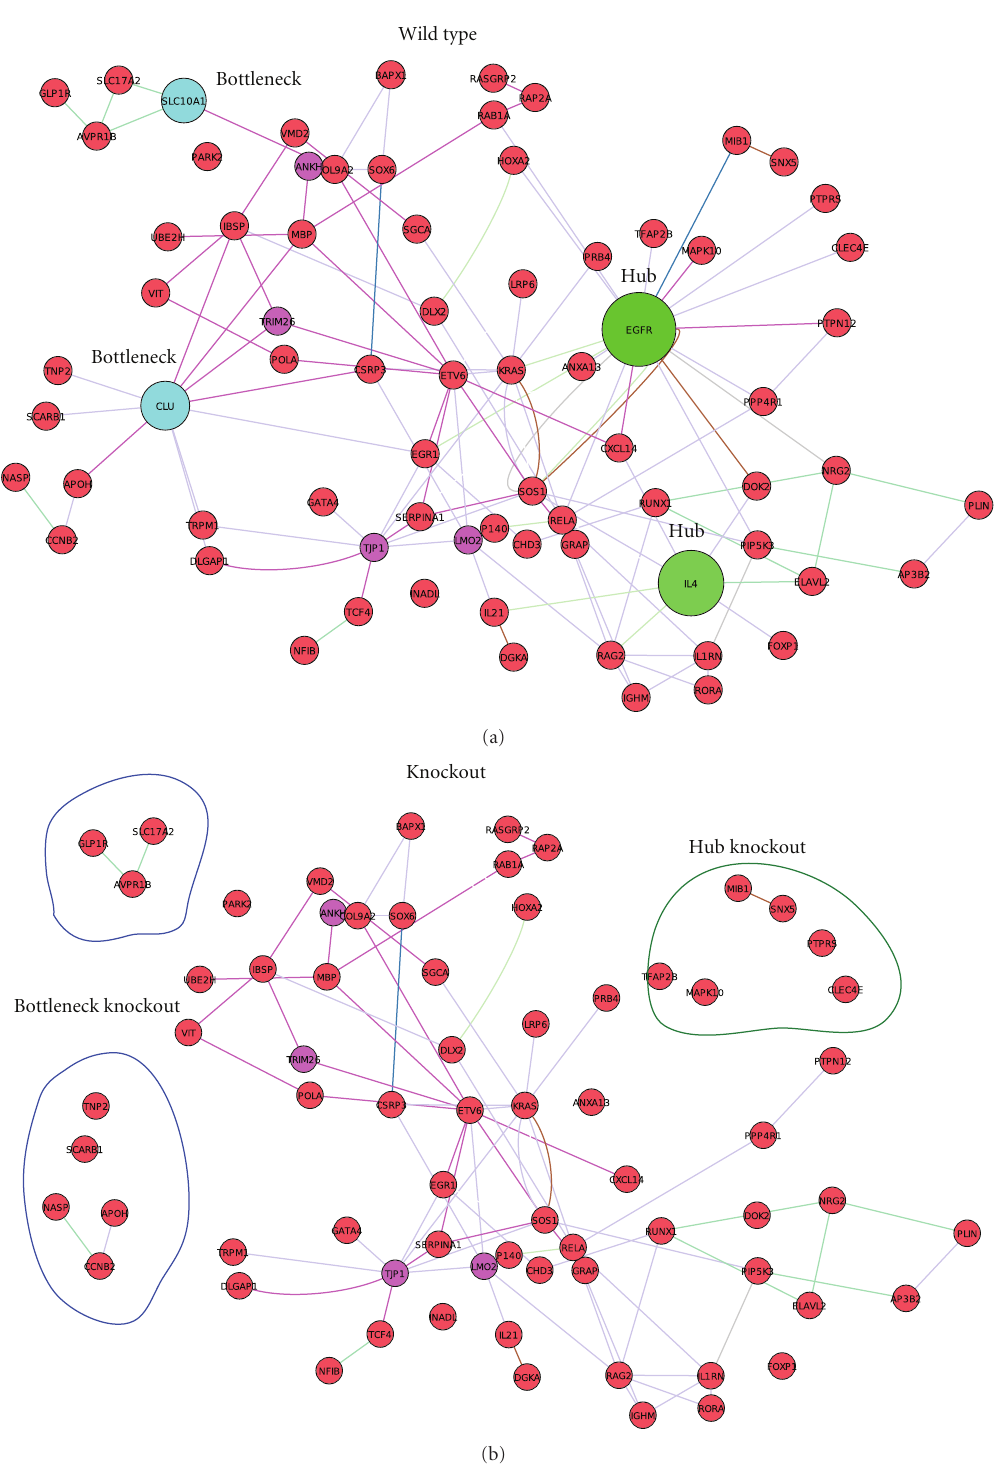
Figure 5: Samples of in silico gene knockout in the network enhanced by HCMV entry. (a) Entire wild-type network enhanced by HCMV entry with highlighted genes with big size to be knocked out. Blue: potential bottleneck nodes; green: potential hubs. (b) Knocking out hubs and bottlenecks alter network structure. Knocking out hubs decreases local subnetwork linkages while most of their linked neighbors would not a ff ected. Highlighted in green circle are the consequences of knockout EGFR and IL4 with only 6 genes and 1 gene, respectively, a ff ected by knockout, but most of genes linked to EGFR and IL4 still link to the network after knockout. Conversely, knocking out bottleneck nodes breaks down the entire network into at least two separated networks as highlighted in blue